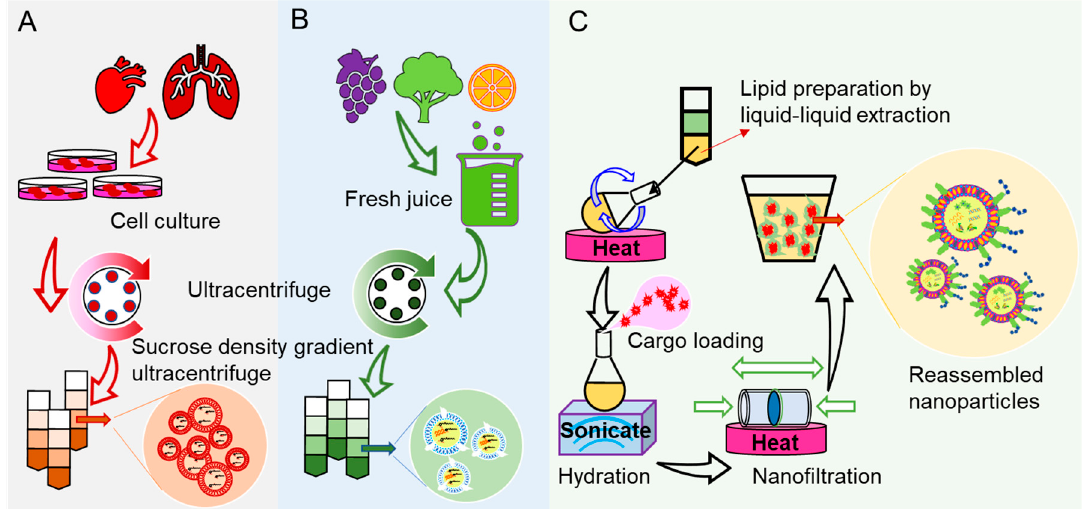
Figure 3. Strategies for making nontoxic oral nanoformulations (NFs): ( A ) preparation of mammalian cell-derived exosomes; ( B ) isolation of plant-derived nanoparticles; ( C ) engineering natural-derived nanoparticles from extracted lipids. Nanomaterials . 2020, 10, 1424; DOI:10.3390/nano10071424 [140].